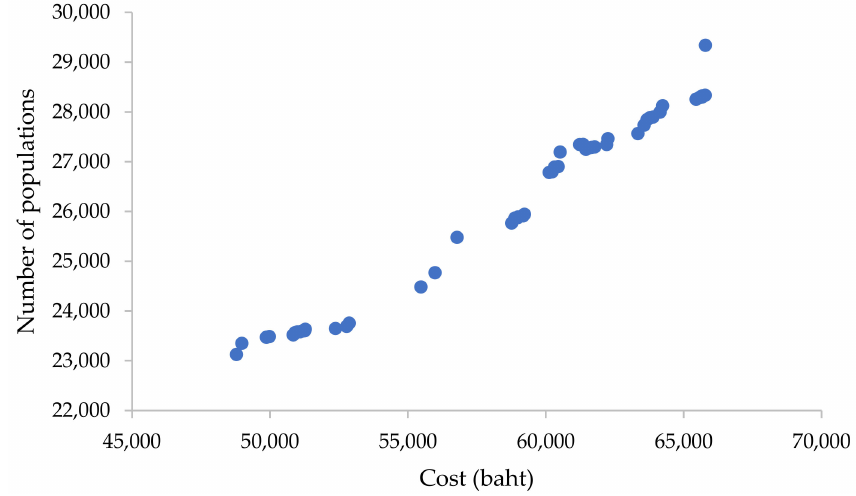
Figure 6. Pareto front of GA.